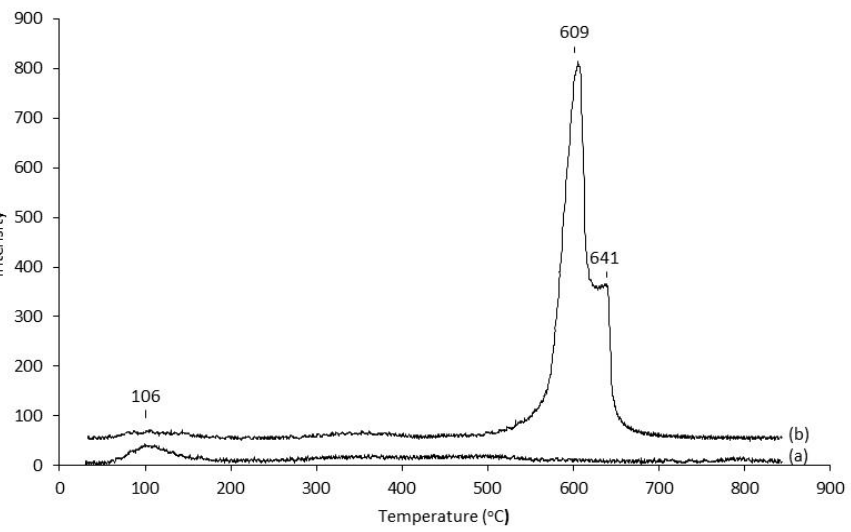
Figure 5. NH 3 -TPD profiles of (a) CsPW and (b) HPW.